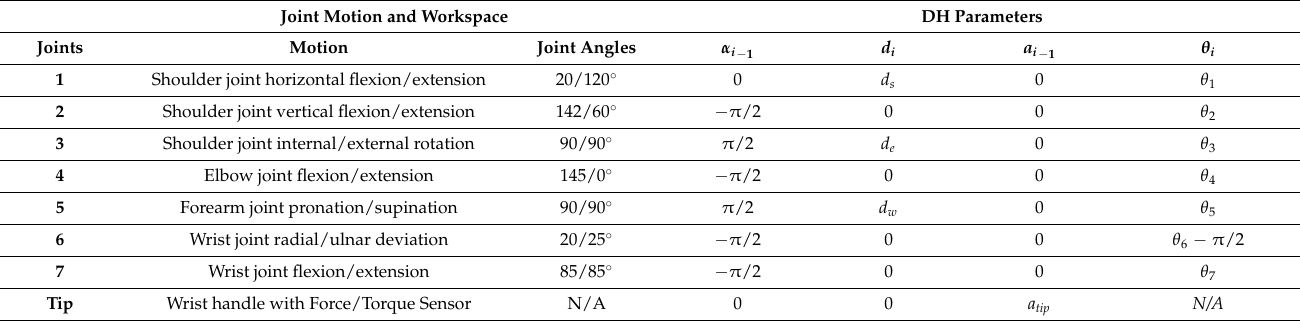
Table 3. SREx ’s workspace and modified Denavit–Hartenberg (DH)